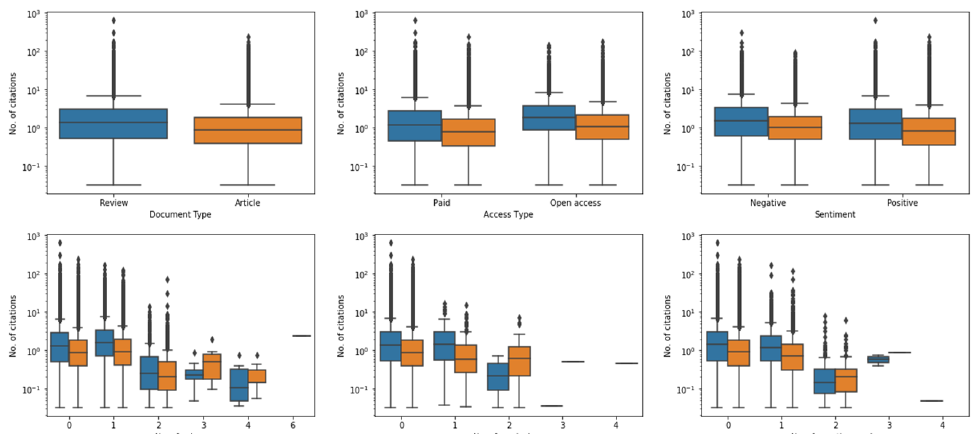
Figure 3. Boxplots representing the number of (normalized) citations in review and original arti- cles (above, left-hand side), subscription-based and open access publications (above, middle), pub- lications with negative or positive title sentiment score (above, right-hand side) and citation count based on the number of colons in the title (below, left-hand side), semicolons (below, middle) or question marks (below, right-hand side). For all the plots, review papers are indicated in blue and original articles in orange.